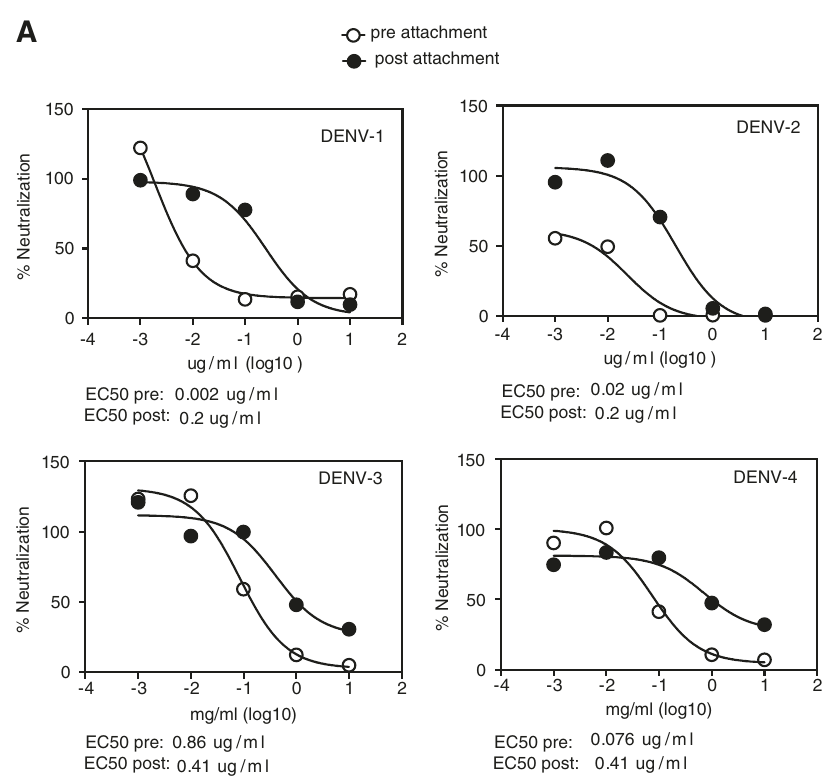
Fig. 5 Mode of action of antibody SIgN-3C-LALA. a Pre and post-attachment neutralization assay with U937-DC-SIGN cells. EC50 values for the pre and post-setup are shown below the graphs. Symbols are means of duplicates and results are representative of one experiment out of two